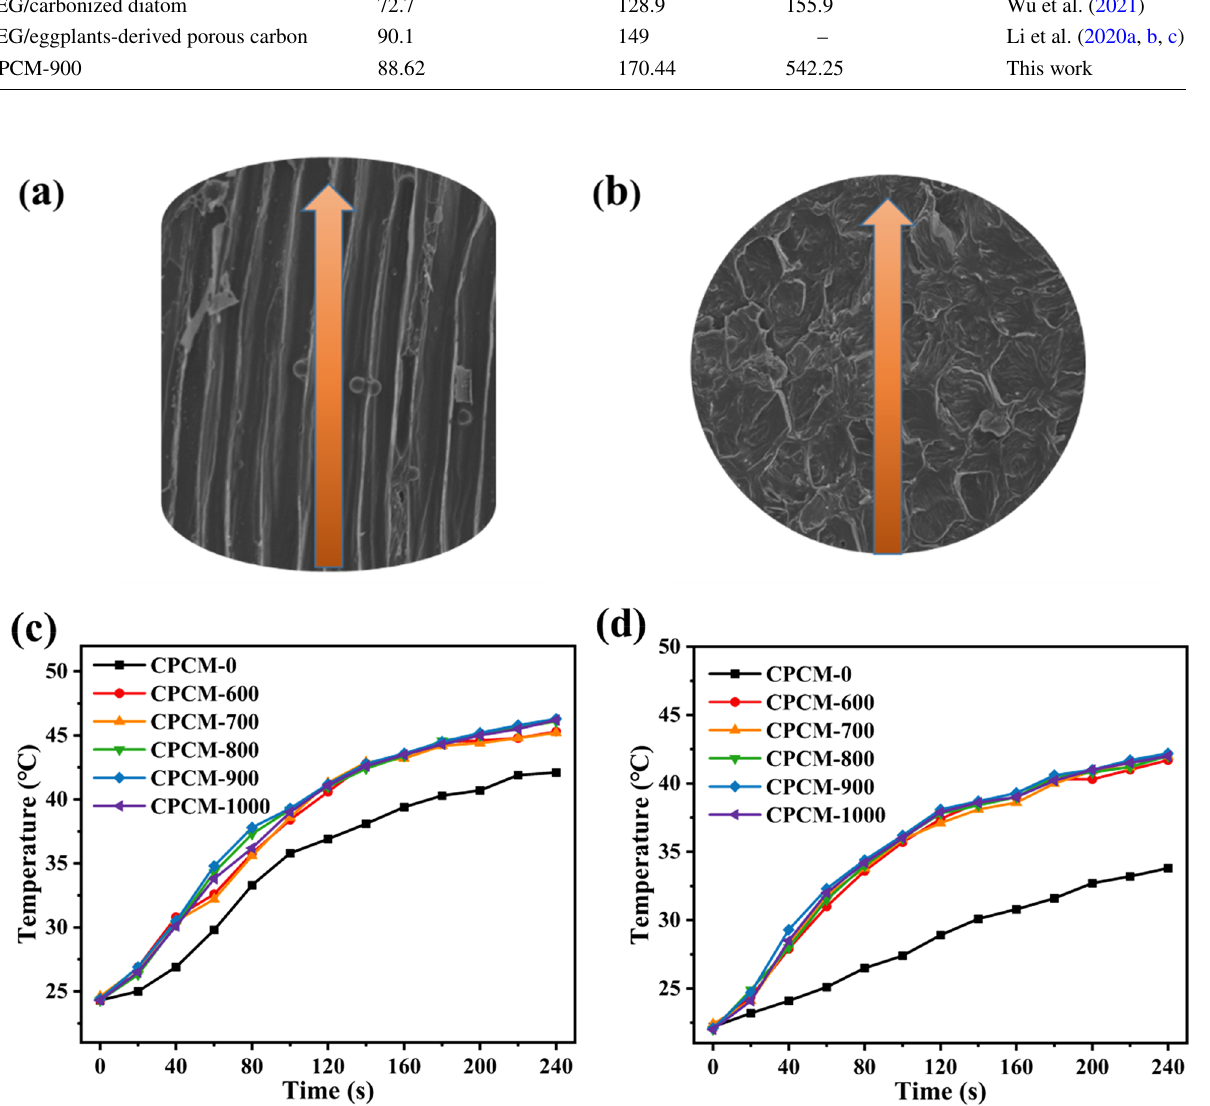
Fig. 11 a Radial and b lateral thermal transfer schematic diagrams of CPCMs, c radial and d lateral thermal transfer T–t curves per unit length